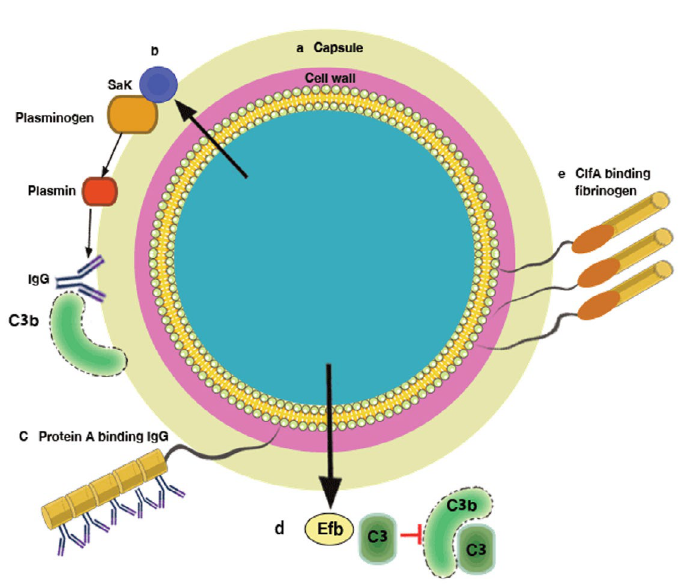
Fig. 5. Mechanisms by which Staphylococcus aureus avoids opsonophagocytosis: (a) the capsular polysaccharide, which can compromise neutrophil access to bound complement and antibody; (b) the extracellular staphylokinase (Sak), which activates cell-bound plasminogen and cleaves IgG and C3b; (c) protein A with 5 IgG Fc-binding domains; (d) fibrinogen-binding protein (Efb), which binds complement factor C3 and blocks its deposition on the bacterial cell surface. Complement activation beyond C3b attachment is prevented, thereby inhibiting opsonization. (e) ClfA, which binds the γ chain of fibrinogen [19, 21, 30, 33, 34]